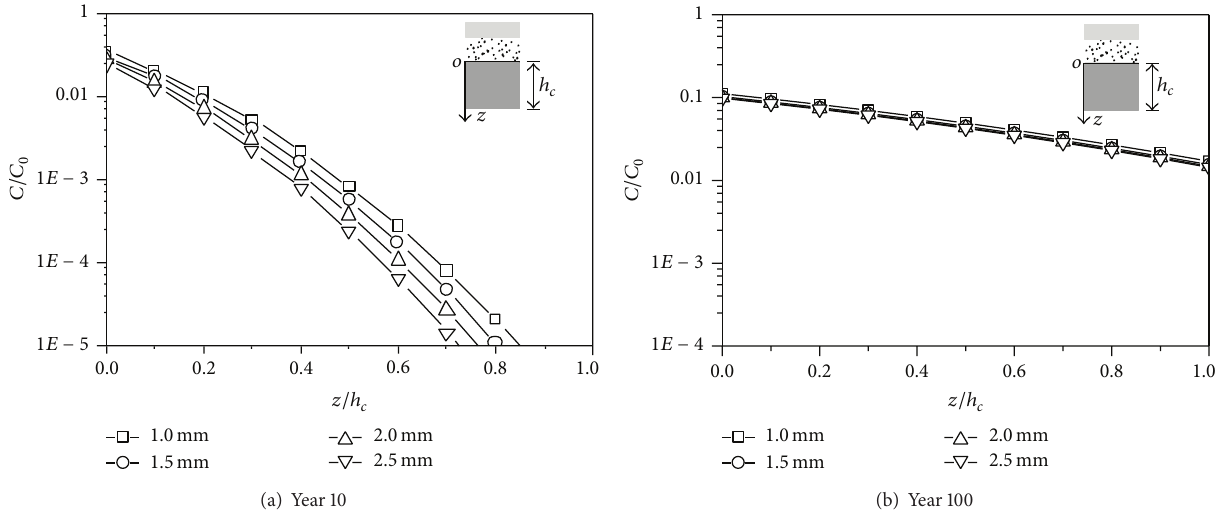
Figure 6: Comparison of numerical results with different GM thicknesses.